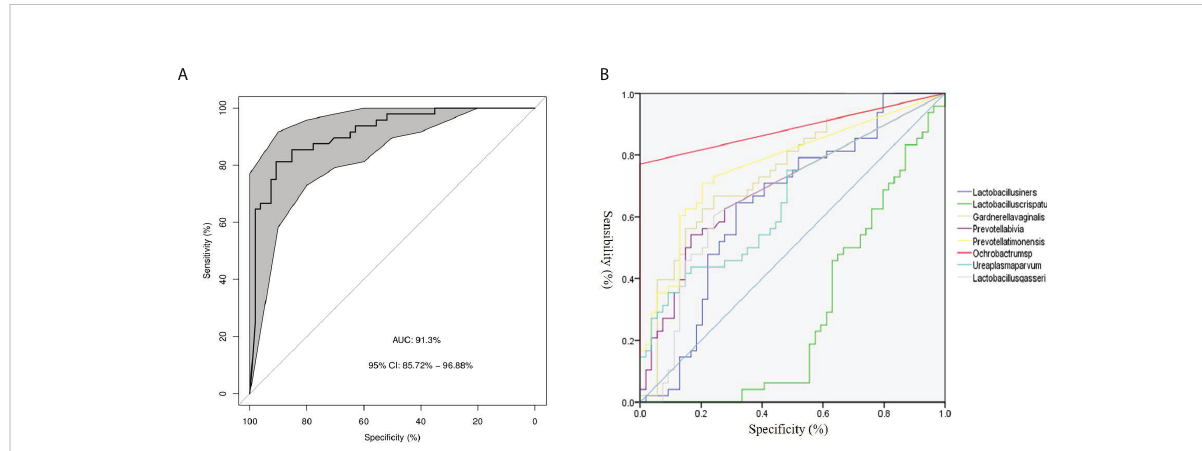
FIGURE 3 Disease classi fi cation based on vaginal microbiota signature. (A) The ROC curve of 8 different species. (B) The ROC curves of 8 different